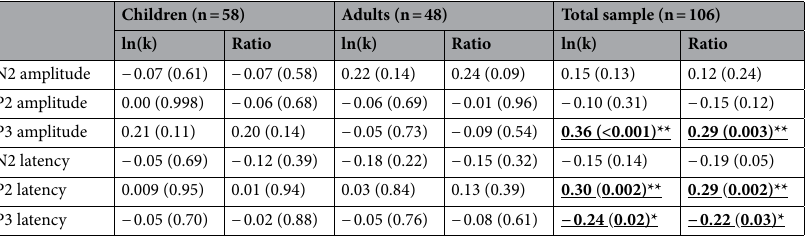
Table 8. Pearson’s correlations among ln(k) values, ERP component amplitudes and ERP component latencies, and Spearman’s correlations among the ratio of immediate choices, ERP component amplitudes and ERP component latencies. *Significance ≤ 0.05; **Significance ≤